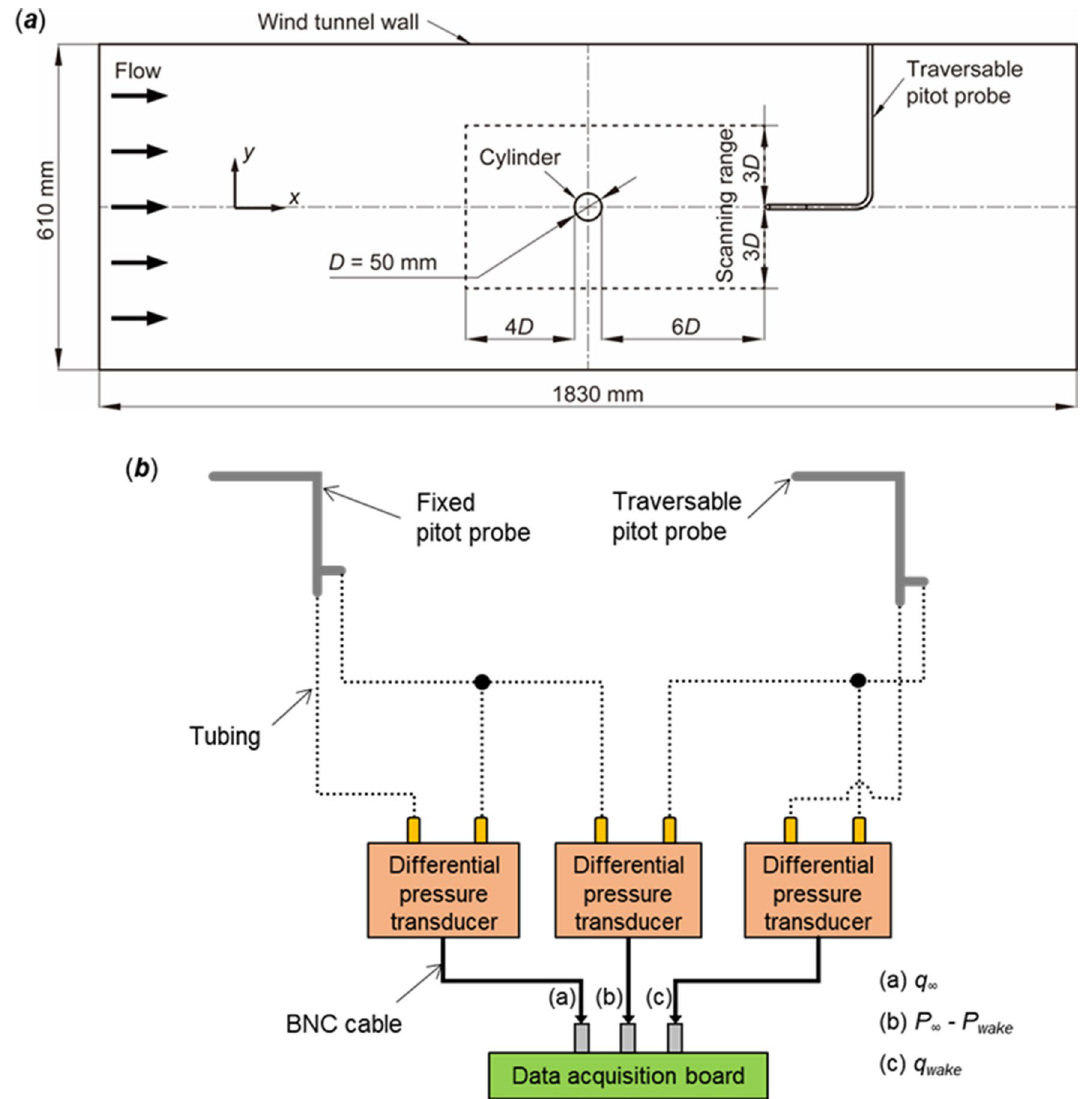
Figure 2. Schematic of the wake profile measurement. ( a ) Configuration of cylinder model and pitot probes in the wind tunnel. ( b ) Setup of differential pressure measurement using pitot